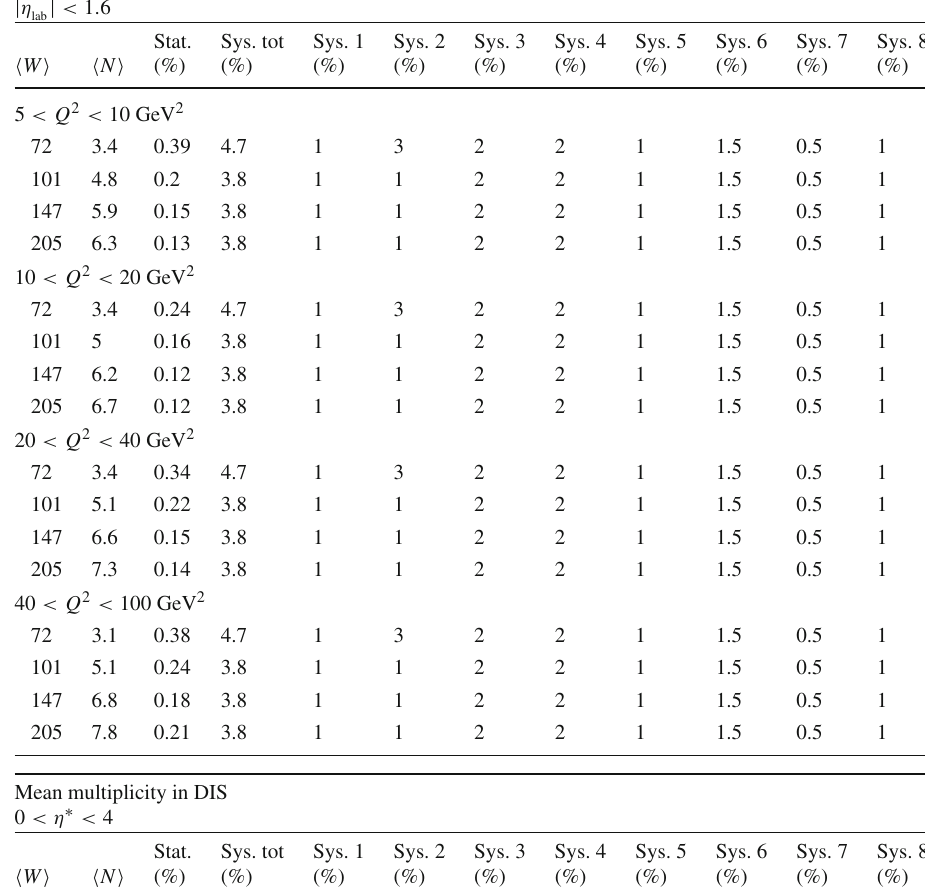
Mean multiplicity in DIS | η | < 1 . 6 lab Stat.